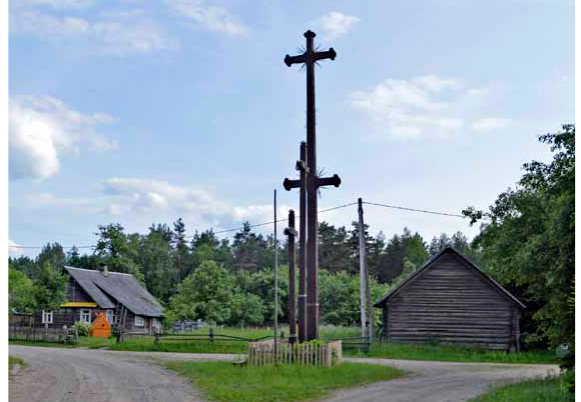
fig. 25. Semantic signs – crosses form internal spaces of old lithuanian villages (the Musteikos village in the Varėna district). I. Povilaitienė